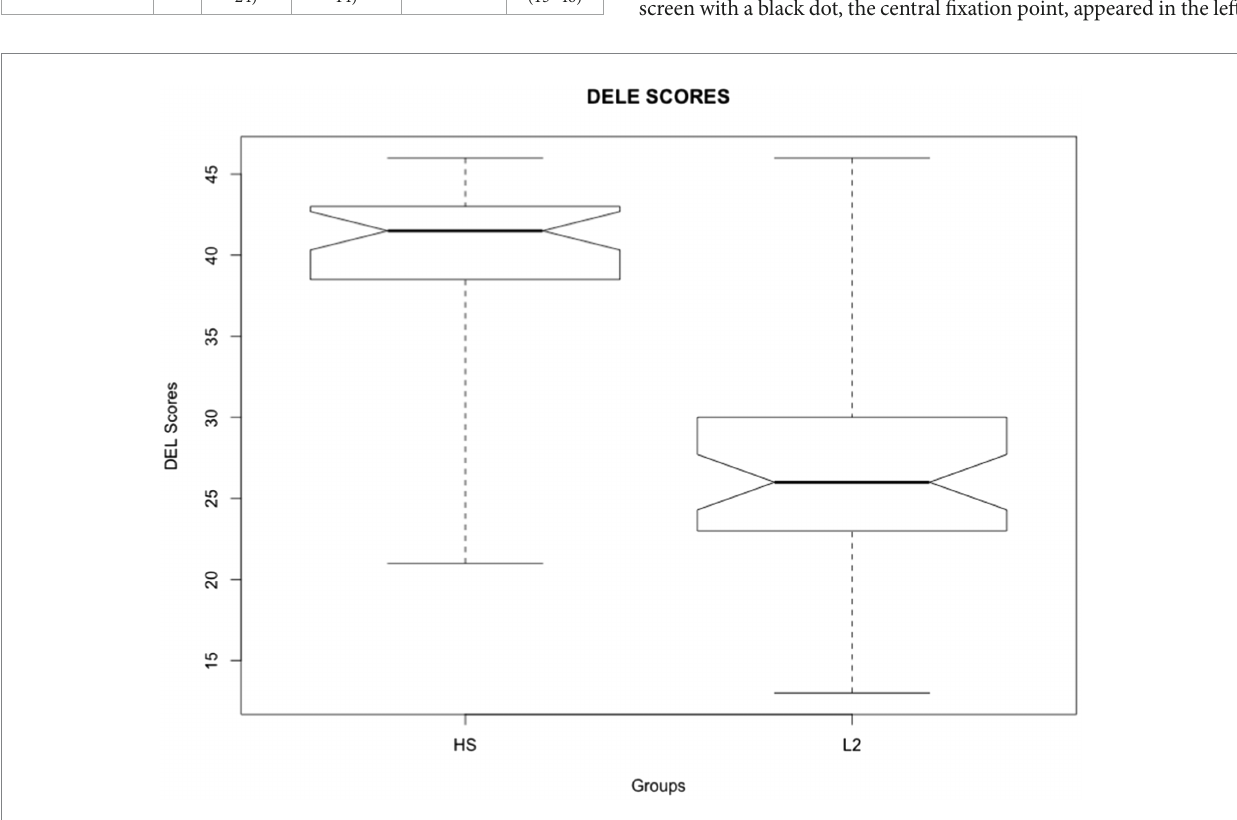
FIGURE 1 DELE scores for the heritage speakers and L2